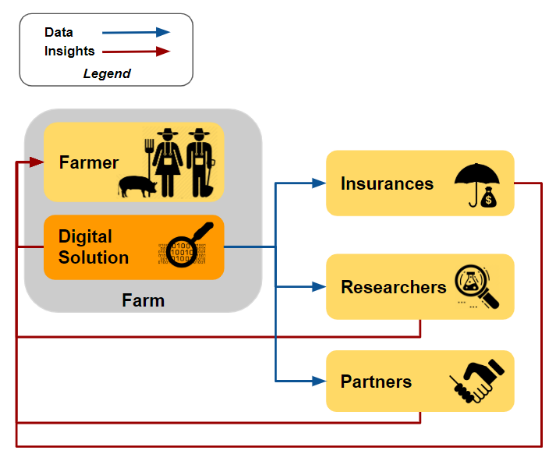
Fig. 8. Proposed business model